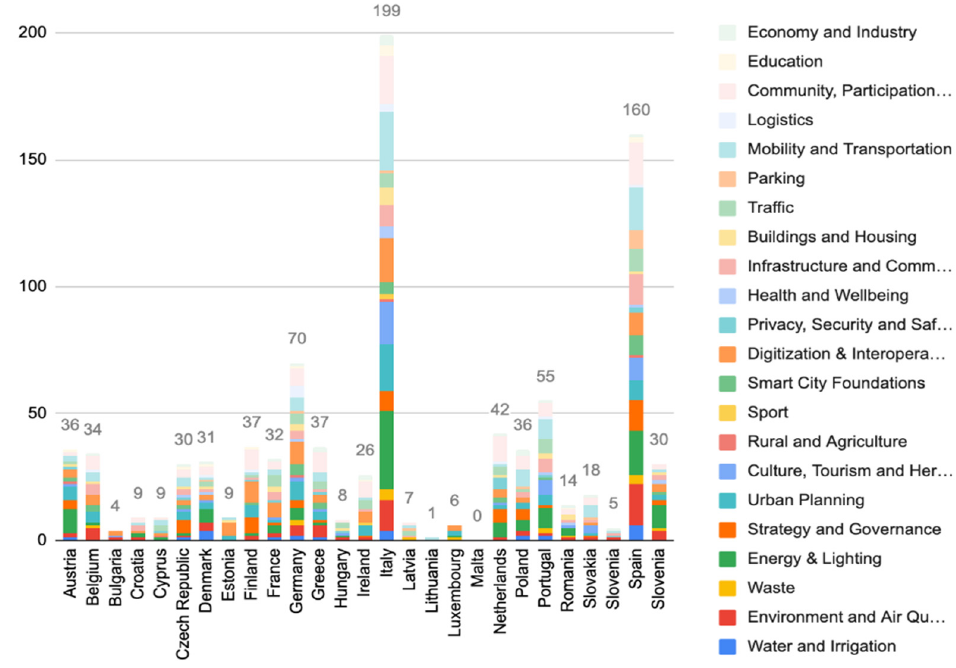
Figure 7. Countries’ Smart City initiatives divided by category.